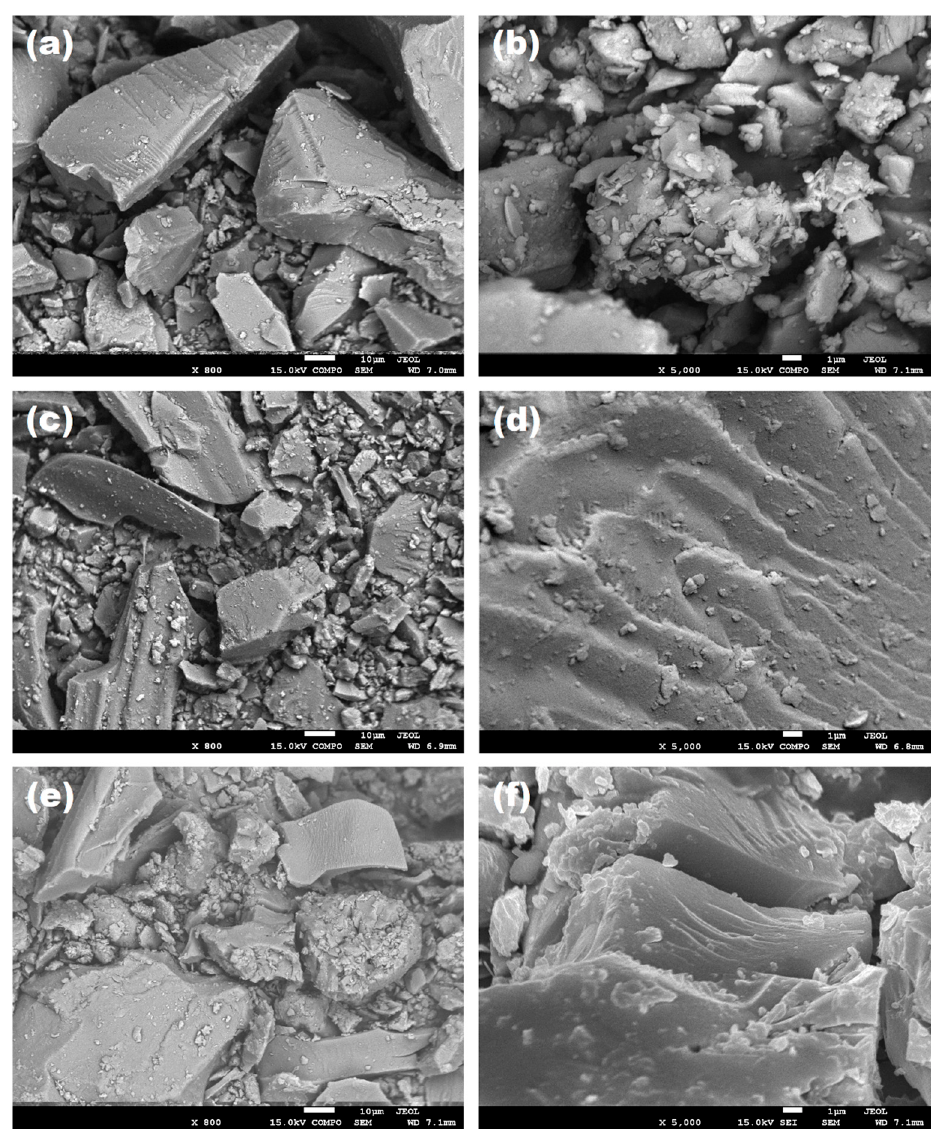
Figure 2. The surface morphological characteristics of the SEM pore-fracture system in ( a , b ) coal C1, ( c , d ) coal C2, ( e , f ) coal C3. Magnification = 800 ( left ), magnification = 5000 ( right ).